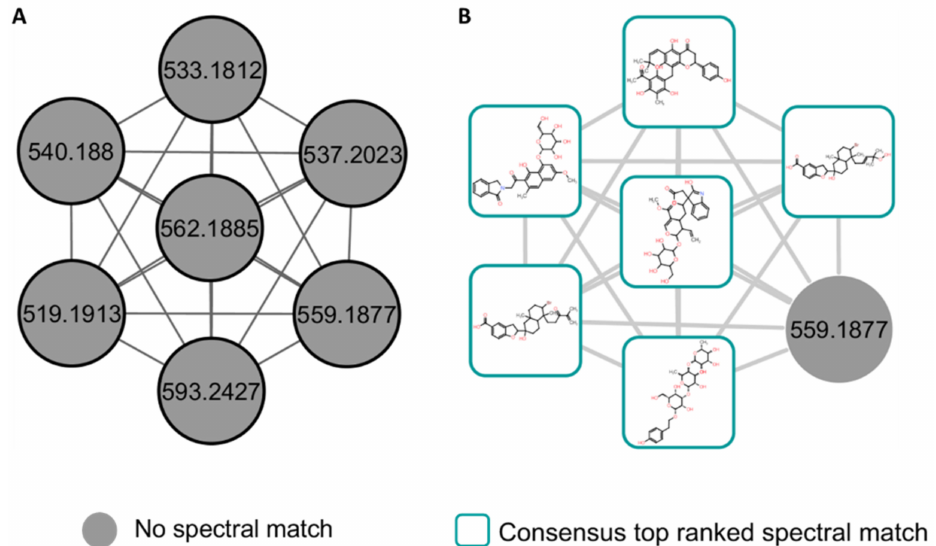
Figure 5. Molecular network family clusters of unidentified chemical compound class from maize leave extracts analyzed in positive electrospray ionization (ESI+). ( A ) Molecular network family with unknown structural annotations (grey nodes) and the resultant ( B ) top ranked NAP Consensus structural annotations (cyan